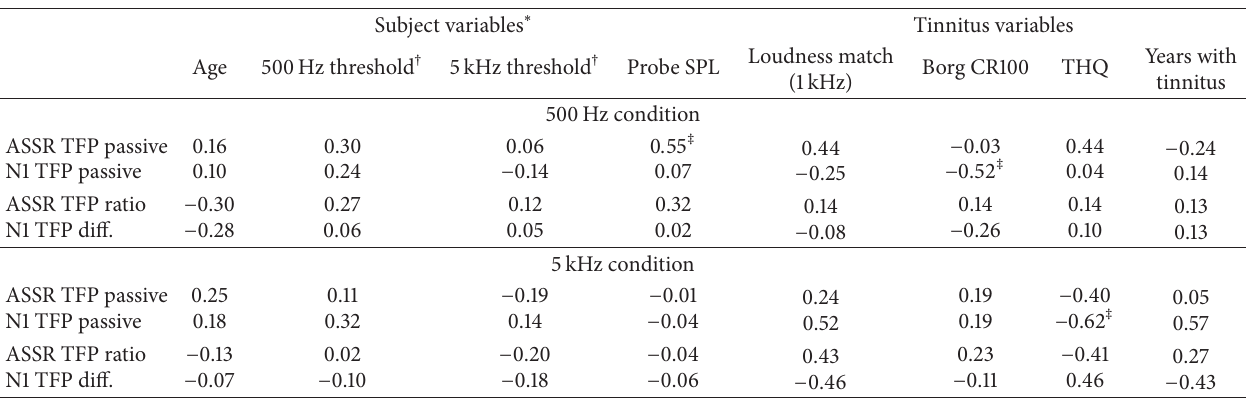
Table 2: Relationship of ASSR and N1 responses on passive blocks and ASSR and N1 attention effects to subject and tinnitus variables. The table entries are product-moment correlations reported for the 500 Hz and 5 kHz conditions